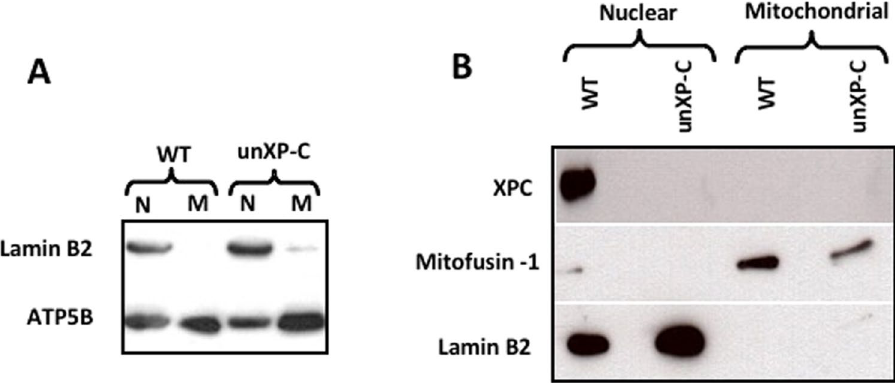
Figure 6. Expression and localization of the XPC protein in the cell. ( A ) Purity of mitochondrial extracts was checked by western blotting, using 10 µ g of nuclear (N) or mitochondrial (M) fractions from MRC-5 (WT) or XP4PA (unXP-C) per lane. Lamin B2 was used as nuclear marker and ATP5B as mitochondrial. Mitochondrial localization of XPC was analyzed by western blotting. ( B ) Western blotting of mitochondrial and nuclear fractions used 40 μ g of protein and anti-XPC, anti-Mfn1 as mitochondrial marker and anti-Lamin B2 as nuclear